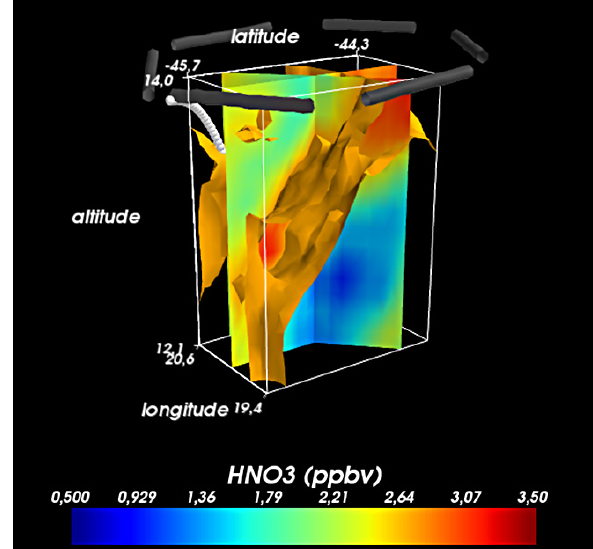
Figure 8. First tomographic observation of a three-dimensional small-scale structure during a HALO flight on 12 September 2012. The HALO flight track at about 14km is indicated by dark grey bars, which form a hexagon. The geographical location of this hexagon is shown in Fig. 7. The tomographic measurement vol- ume below the flight track extends down to about 12km. Individ- ual tangent points are presented by small white spheres. The most prominent feature is a filament of stratospheric air (enhanced HNO 3 values) that is surrounded by tropospheric air. The filament is illus- trated by the 2.7ppbv contour of enhanced HNO 3 values. In addi- tion, some cross sections of HNO 3 values through the tomographic volume are